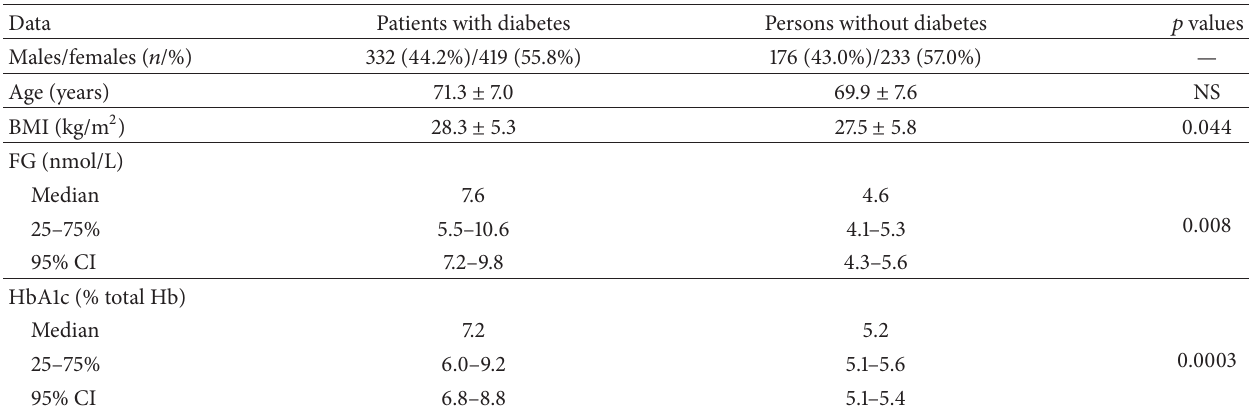
Table1:Baselinedataofallsubjectsstudied:number,age,bodymassindex,fastingglucose,andglycatedhemoglobininpatientswithdiabetes and persons without diabetes.